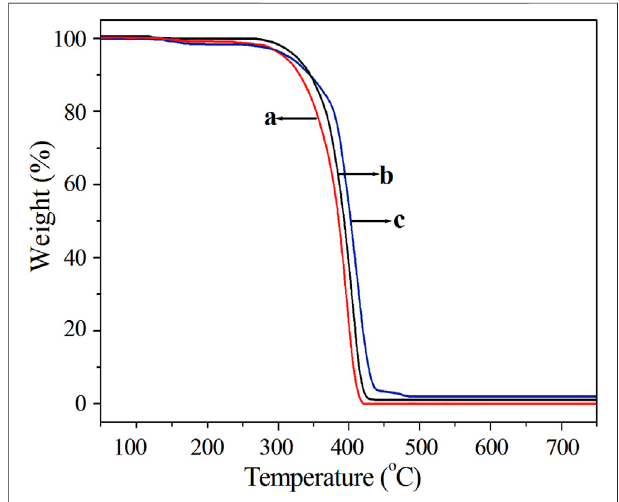
FIGURE 12 | TGA curves: (A) PS, (B) PS/Fe 3 O 4 with an Fe 3 O 4 content of 0.8 wt%(sample2),and (C) PS/Fe 3 O 4 withanFe 3 O 4 contentof2